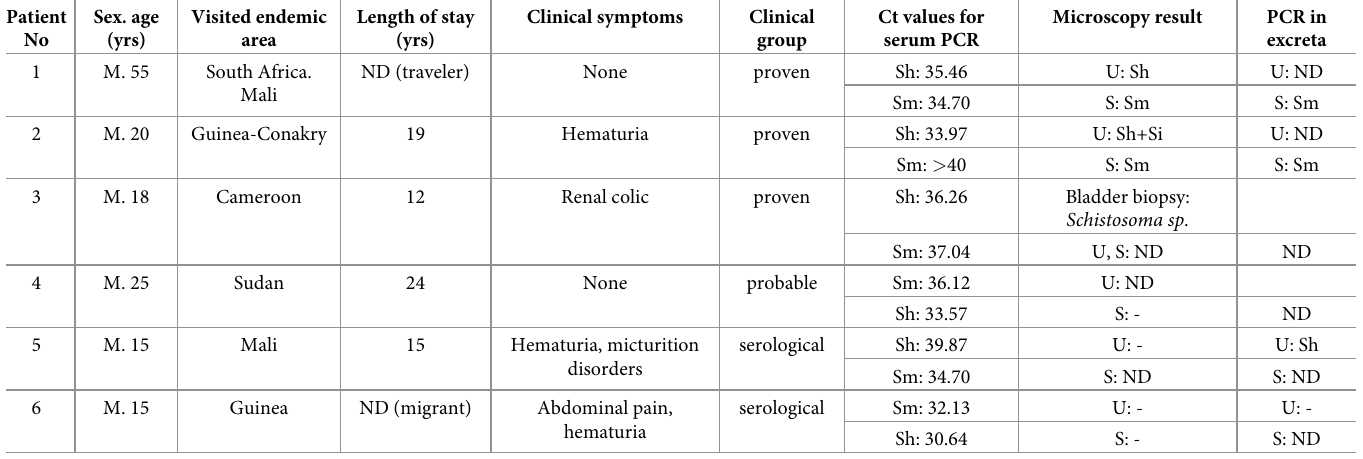
Table 6. Characteristics of patients with simultaneously positive Sm and ShPCRs in serum. Patient